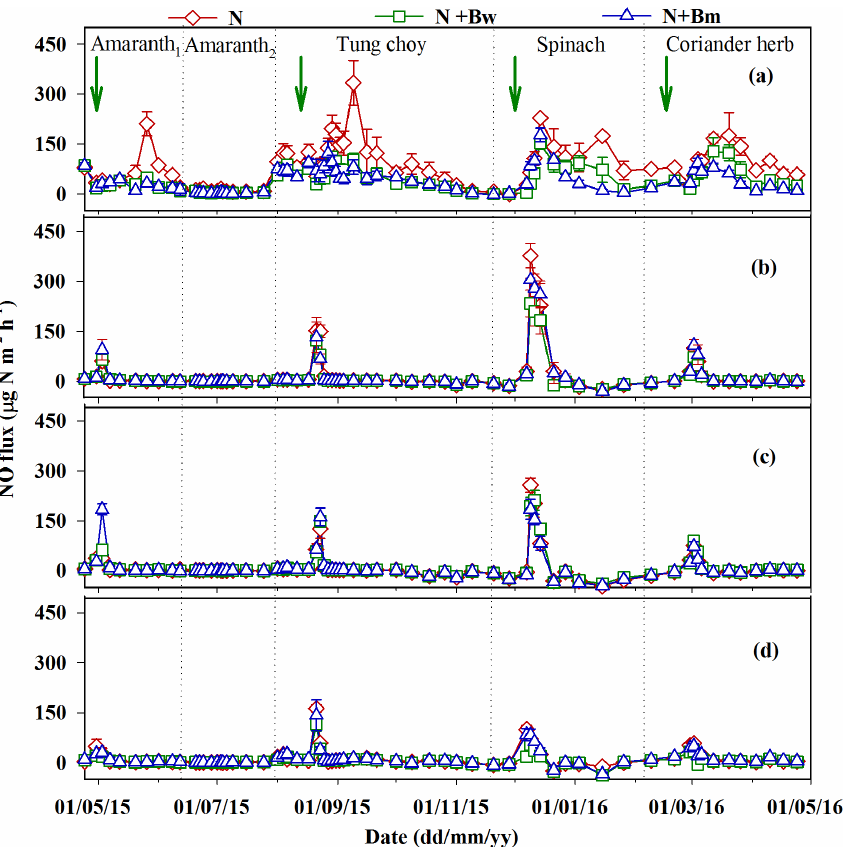
Figure 3. Temporal dynamics of soil NO (µg Nm − 2 h − 1 ± SD, n = 3) fluxes under different treatments in Acrisol (a) , Anthrosol (b) , Cambisol (c) and Phaeozem (d) with five consecutive vegetable crops. The solid arrows indicate fertilization. See Fig. 1 for treatment codes.